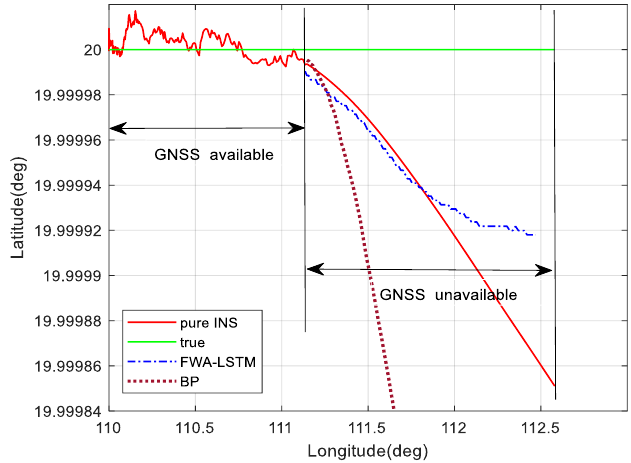
Figure 11. Comparison of prediction performance in small sample conditions.